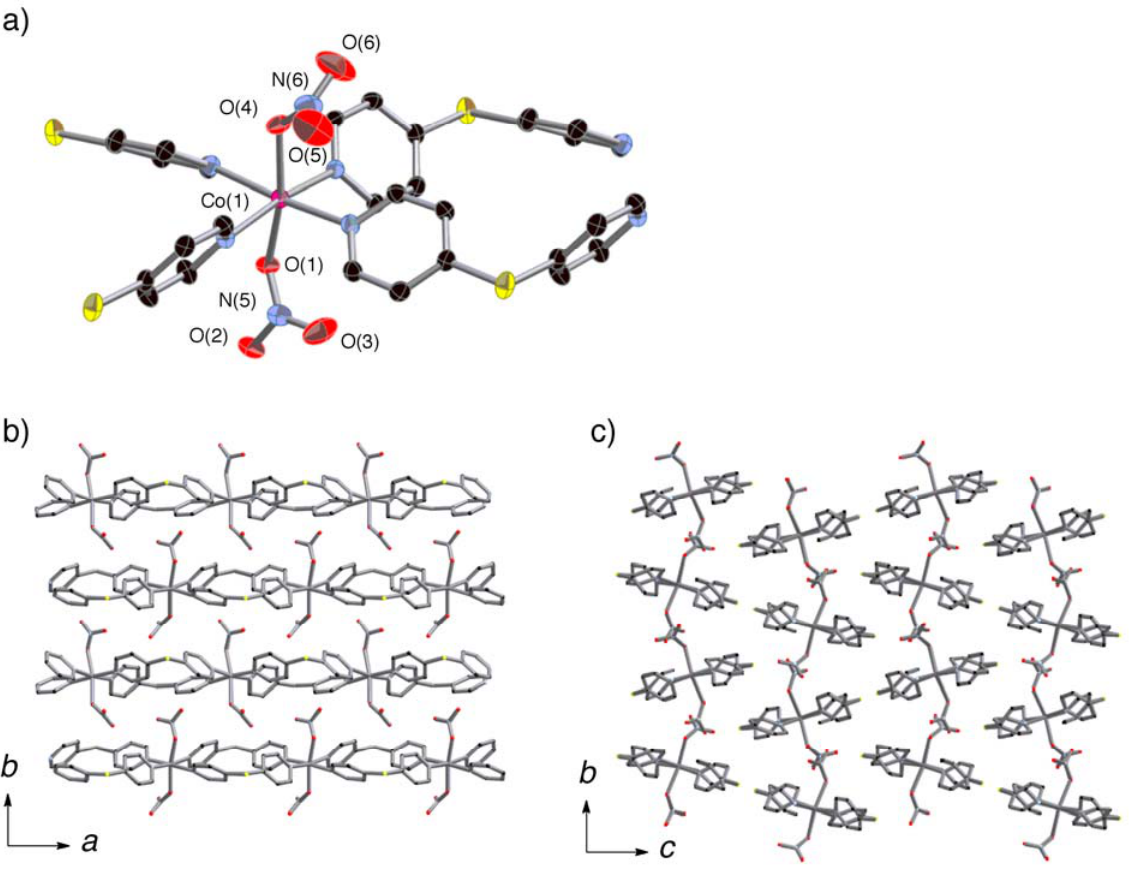
Figure 4. Coordination circumstance of Co center of 3 ( a ). Views of stacking aspect of ( Co - dps ) chains of 3 in the ab plane ( b ), and assembled pattern of the chains along the c 2 axis ( c ). Hydrogen atoms are omitted for